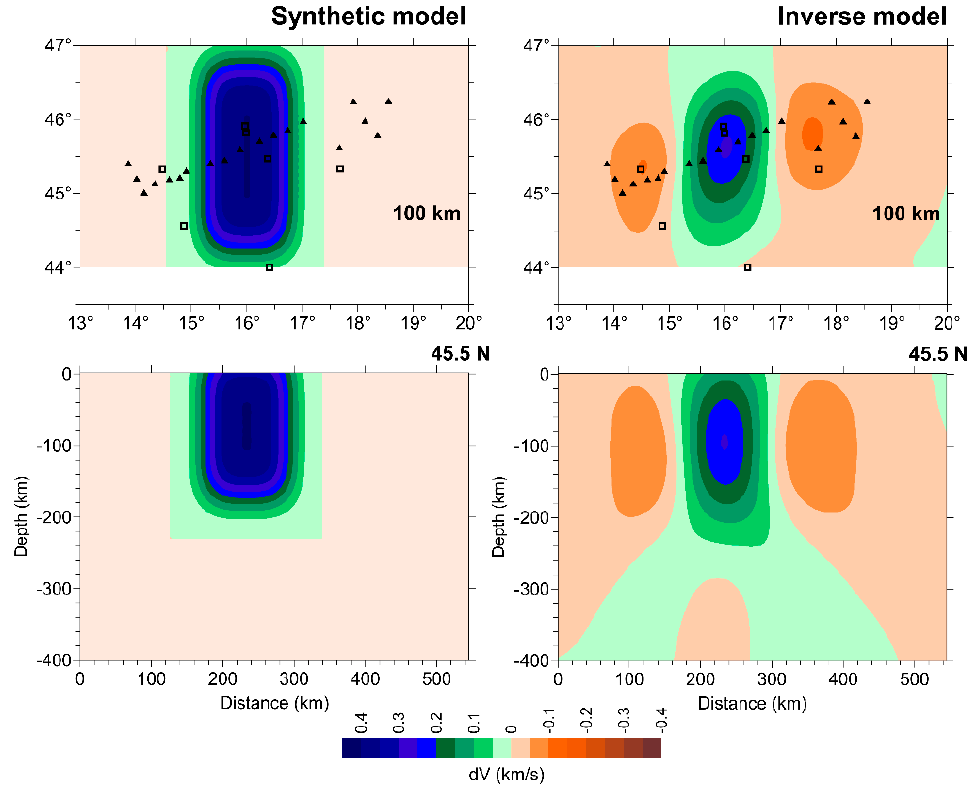
Figure 2. A simple resolution test showing excellent horizontal but poor vertical resolution. The structure, a high velocity block (dV = +0.4 km/s), is shown by the depth slice of 100 km and the vertical cross section of 45.5 ◦ N (left side). The inverse model recovered from synthetic travel-time residuals is shown on the right side [32]. Black squares and triangles represent permanent and temporary seismic stations used to collect the observed data.